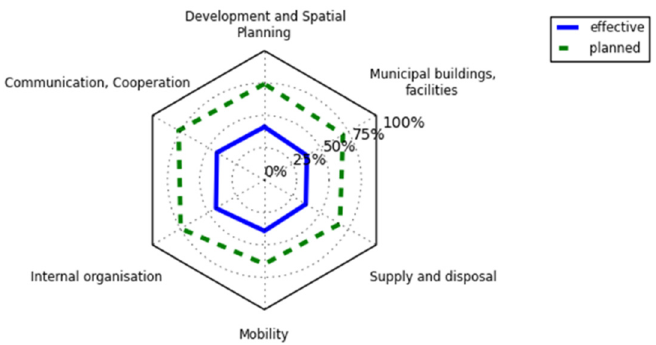
Figure 1. EEA radar chart for the city of Ia ș i, Romania. The blue line shows effective measures and the green dotted line the planned measures.